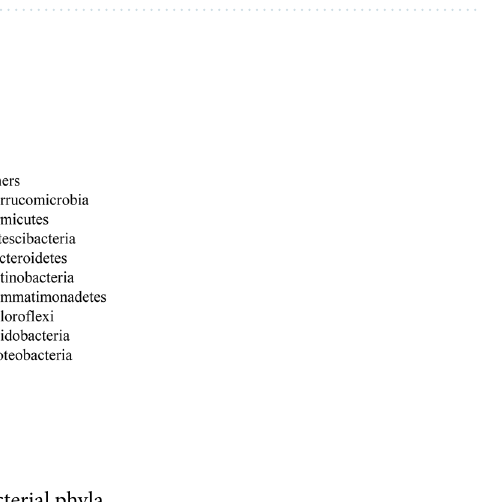
Table 2. Soil physicochemical properties under different treatments. Different letters represented significant difference at P < 0.05.